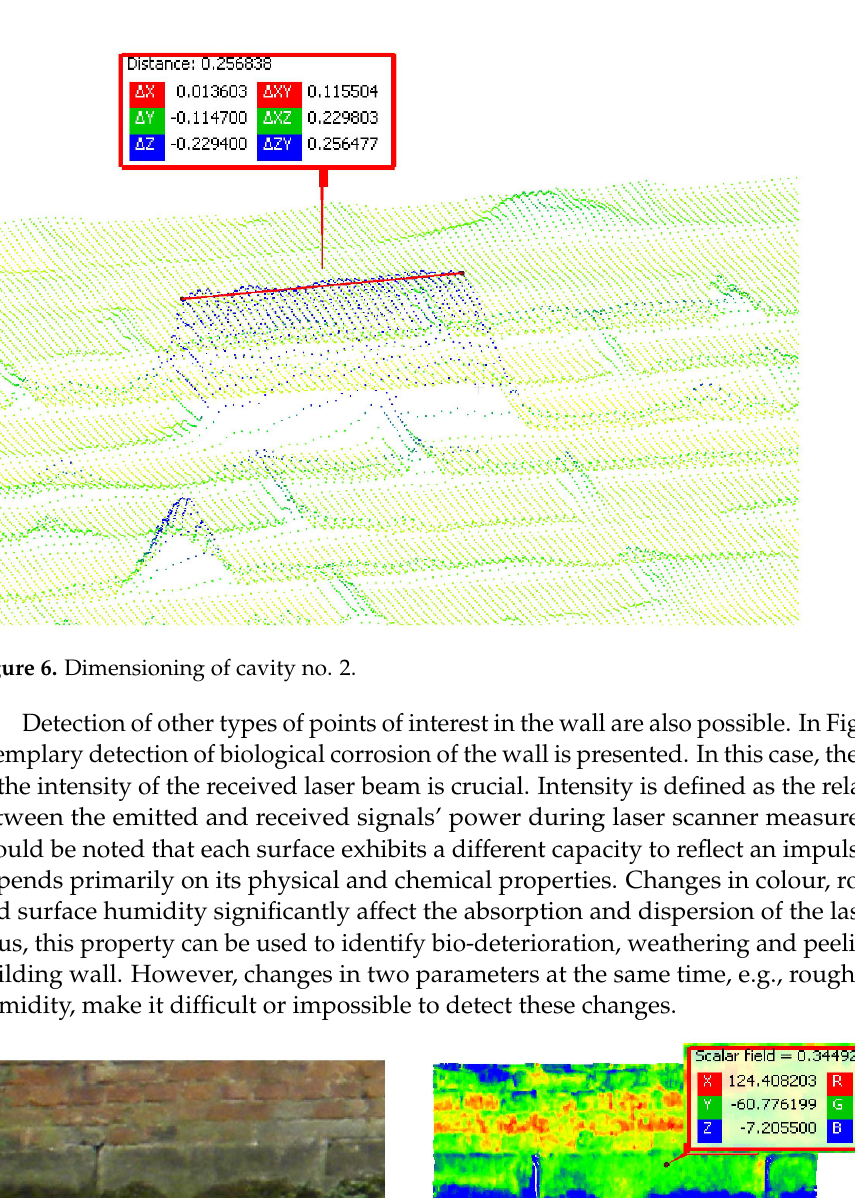
Figure 5. Detection of cavities (missing bricks) in the wall.